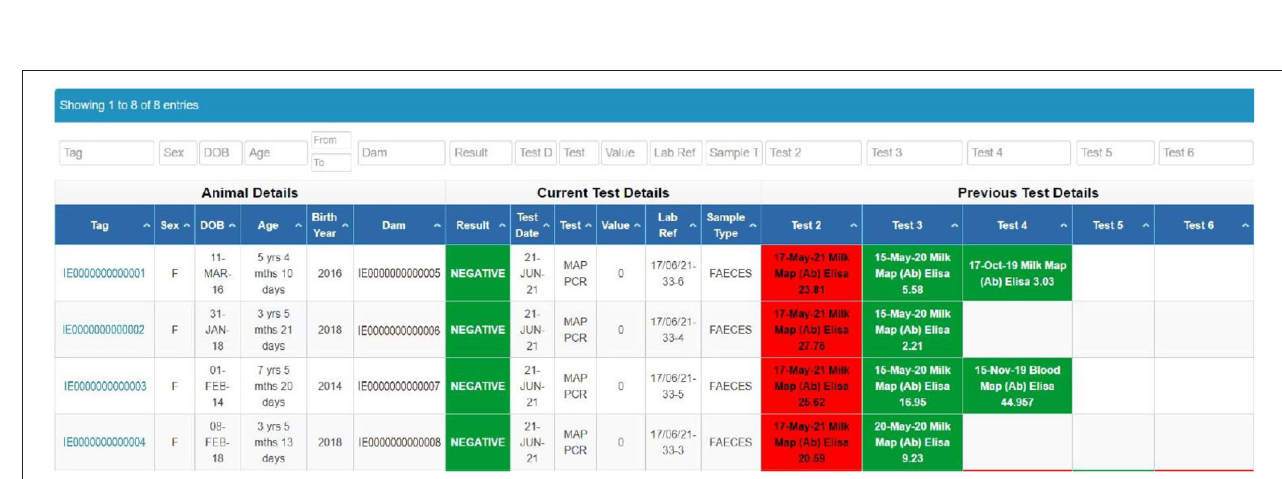
FIGURE 1 | Johne’s herd-level dashboard landing page.